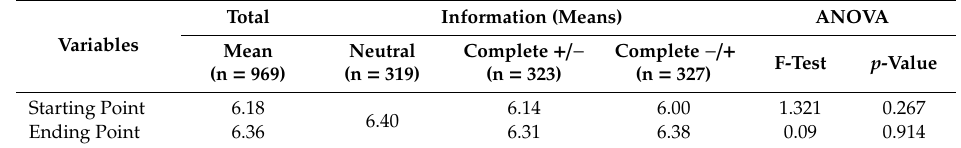
Table 1. One-way ANOVA results for consumers’ answers to the question “Please indicate, on a 0-to-10 scale, your degree of agreement / disagreement with the use of immunocastration (0 = completely disagree, 10 = completely agree)” after receiving di ff erent levels and complexity of information.